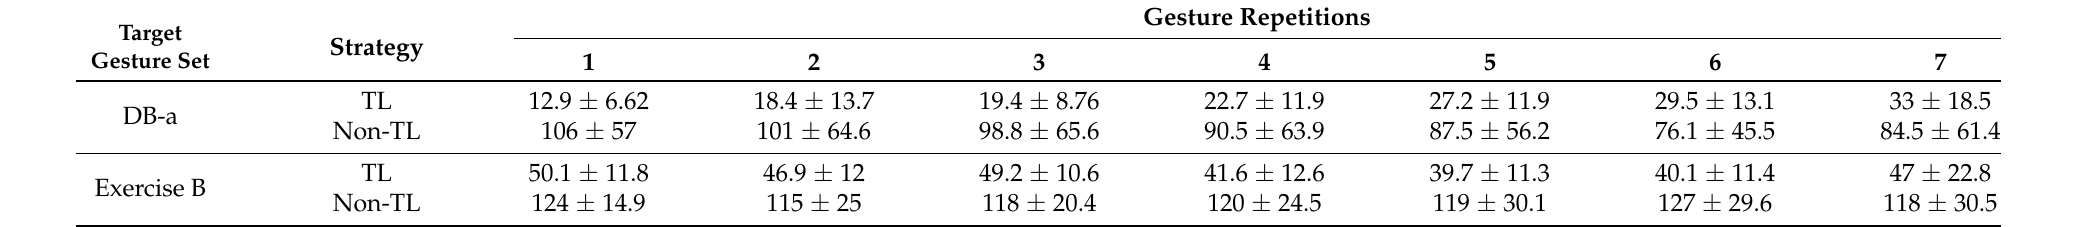
Table 5. The comparison of training time(s) for TL strategy and non-TL strategy for new gesture